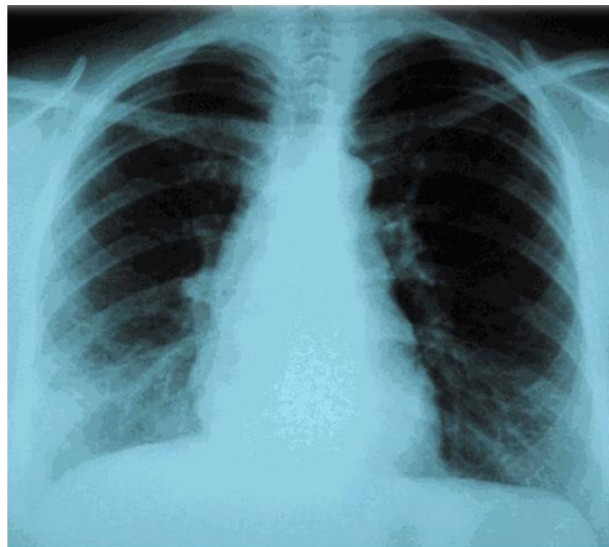
Fig. 1 – Posterior-Anterior (PA) chest X-ray. There is an ill-defined opacity in the right lower lung zone, with some degree of fine reticulation, extending to the lung periphery (Kerley B lines).